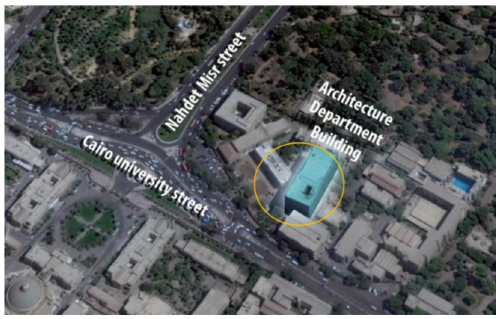
Fig. 4. Layout of Faculty of campus,